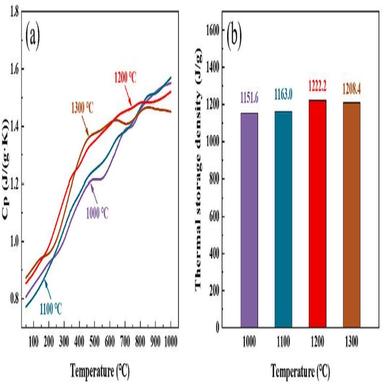
(a) Specific heat and (b) Thermal storage density in the temperature range of 50 ◦C–1000 ◦C of samples with different sintering temperatures.